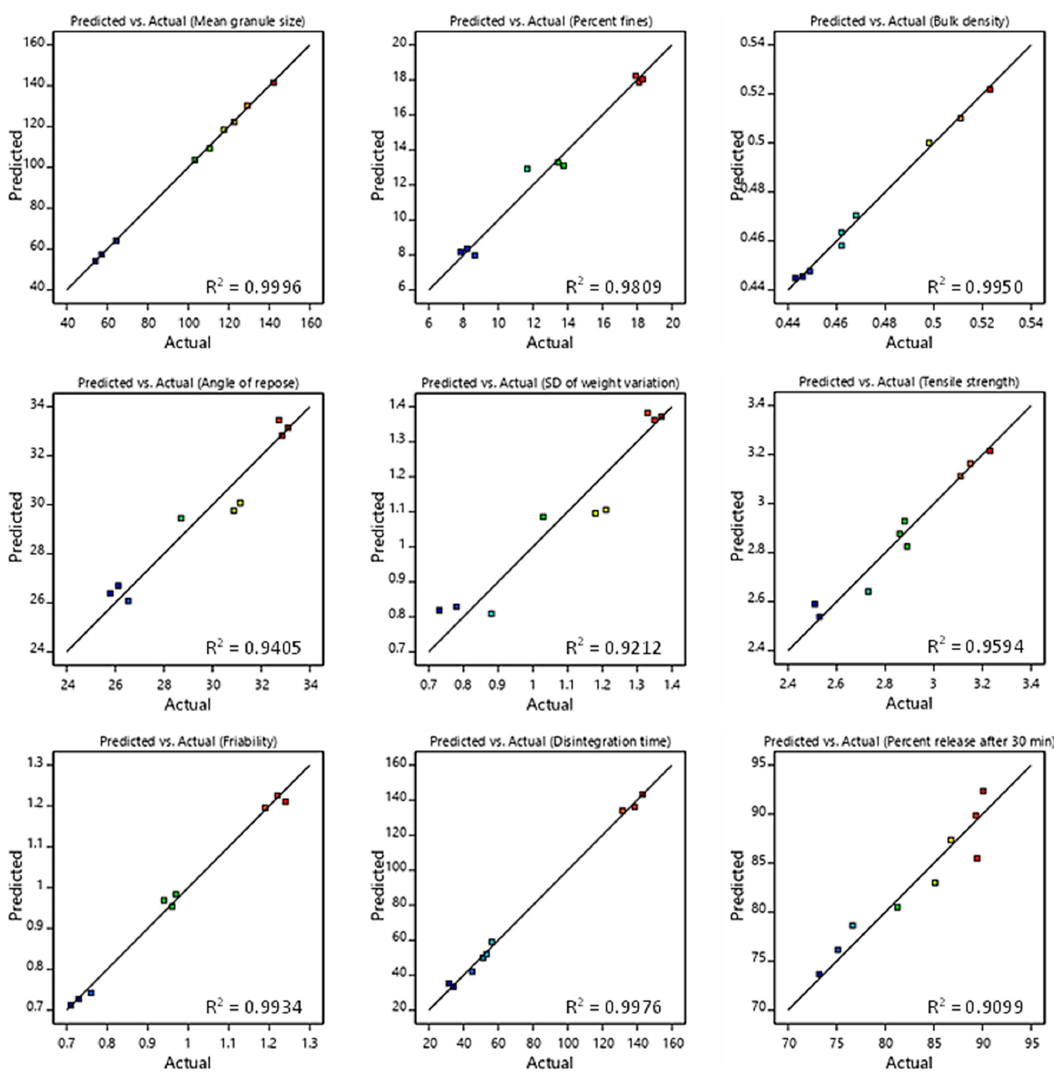
Figure 1. Linear correlation plot relating; mean granule size, percent fines, bulk density, angle of repose, SD of weight variation, tensile strength, friability, disintegration time and drug release after 30 min, between the predicted and the actual values. Table 4. Summary of model fitting and statistical analysis .